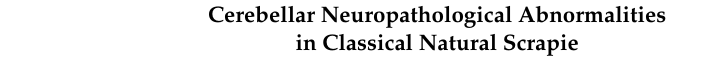
Abnormal PRP Deposits/Deposition